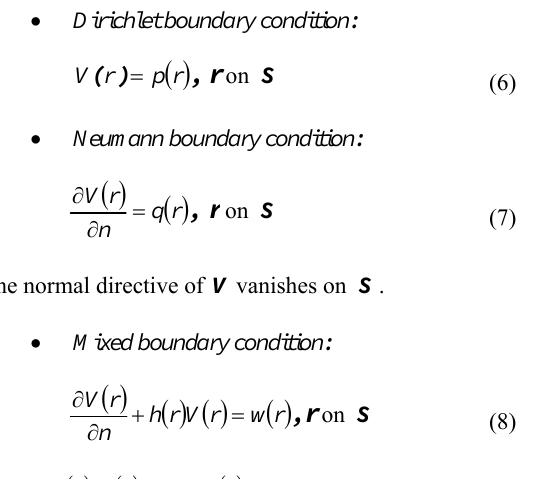
the Figure 3. In the Figure 2, the boundary conditions and are symmetric around the cylinder’s axis and thus, axisymmetric approximation can be deployed. The approximation reduces the complexity of the system, saves time and reduces possibility of